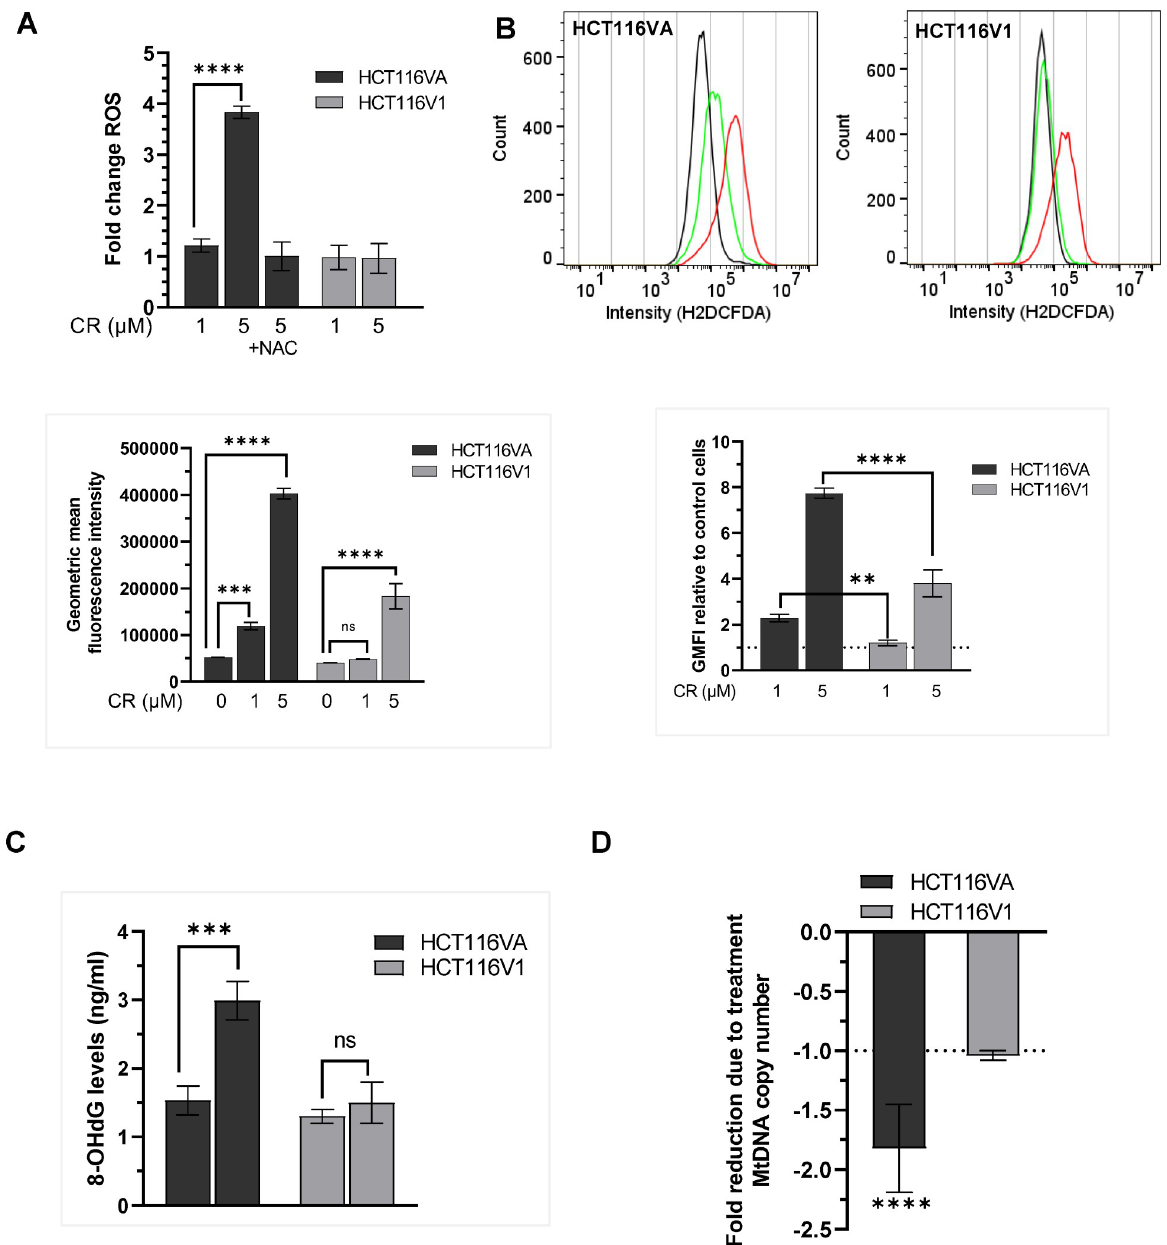
Fig 5. CR increases ROS and decreases the mtDNA copy number in MLH1 deficient cells. (A) ROS measured using the H2DCFDA assay in HCT116VA and HCT116V1 cells treated with CR for 48h and normalized to the corresponding viable cells. Data are shown as mean fold change to untreated control ± STD. (B) Flow cytometry measurement of ROS levels by H2DCFDA fluorescence assay. Plots of the fluorescence intensities of the DCF dye in cells exposed to 1 μ M CR (green color), 5 μ M CR (red color), or untreated cells (black color) for 1 h. Data are given as the ratio of geometric mean fluorescence intensity (GMFI) and GMFI of treated relative to untreated cells (control). (C) The quantification of 8-OHdG levels in HCT116VA and HCT116V1 cells upon treatment of CR. (D) MtDNA copy number. The fold change in mtDNA copy number due to treatment was calculated by 2 - ΔΔ Ct method. Each experiment was performed in triplicate. �� p = 0.002; ��� p = 0.0003; ���� p < 0.0001; ns, not